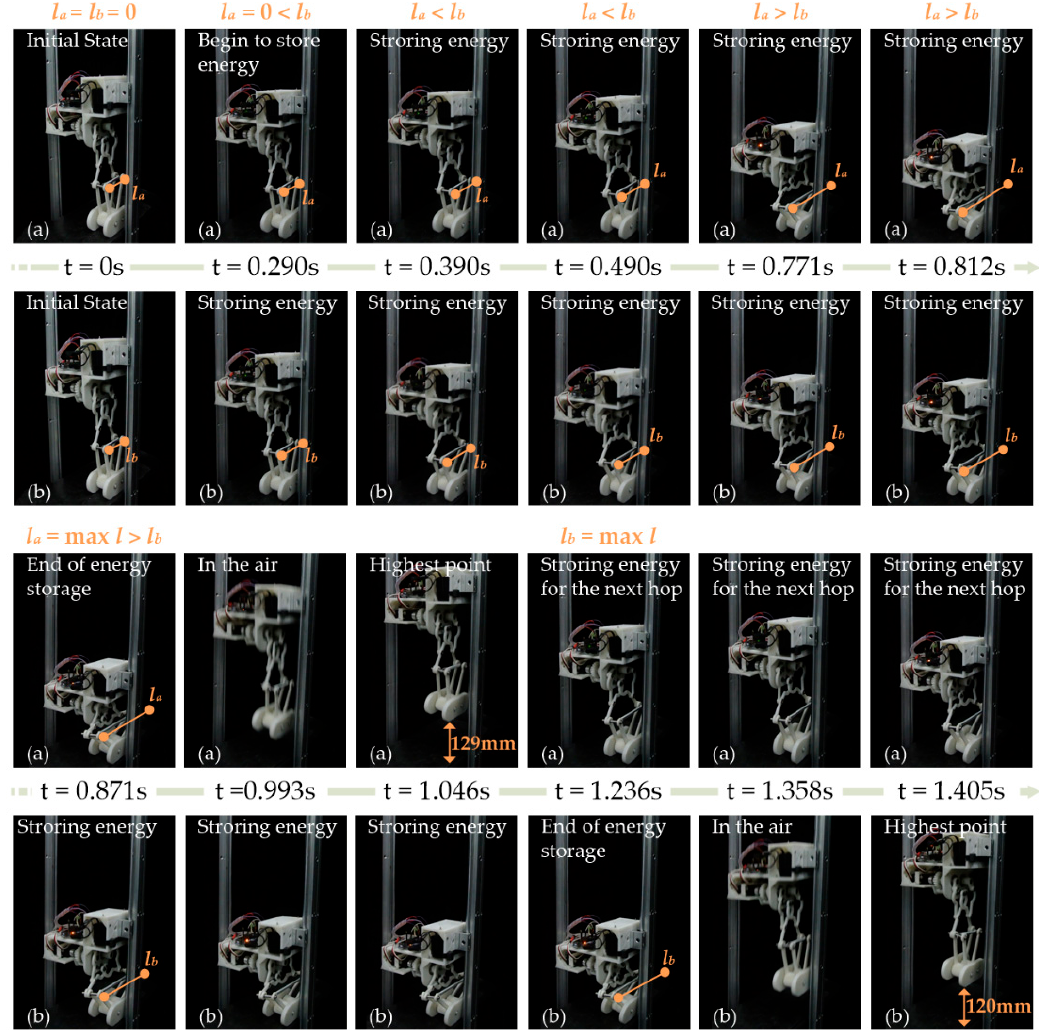
Figure 15. Experimental results comparison for different driving modes. ( a ) The first prototype equipped with a special actuator; ( b ) The second prototype equipped with only a rigid motor. l i means the length of the tension spring.